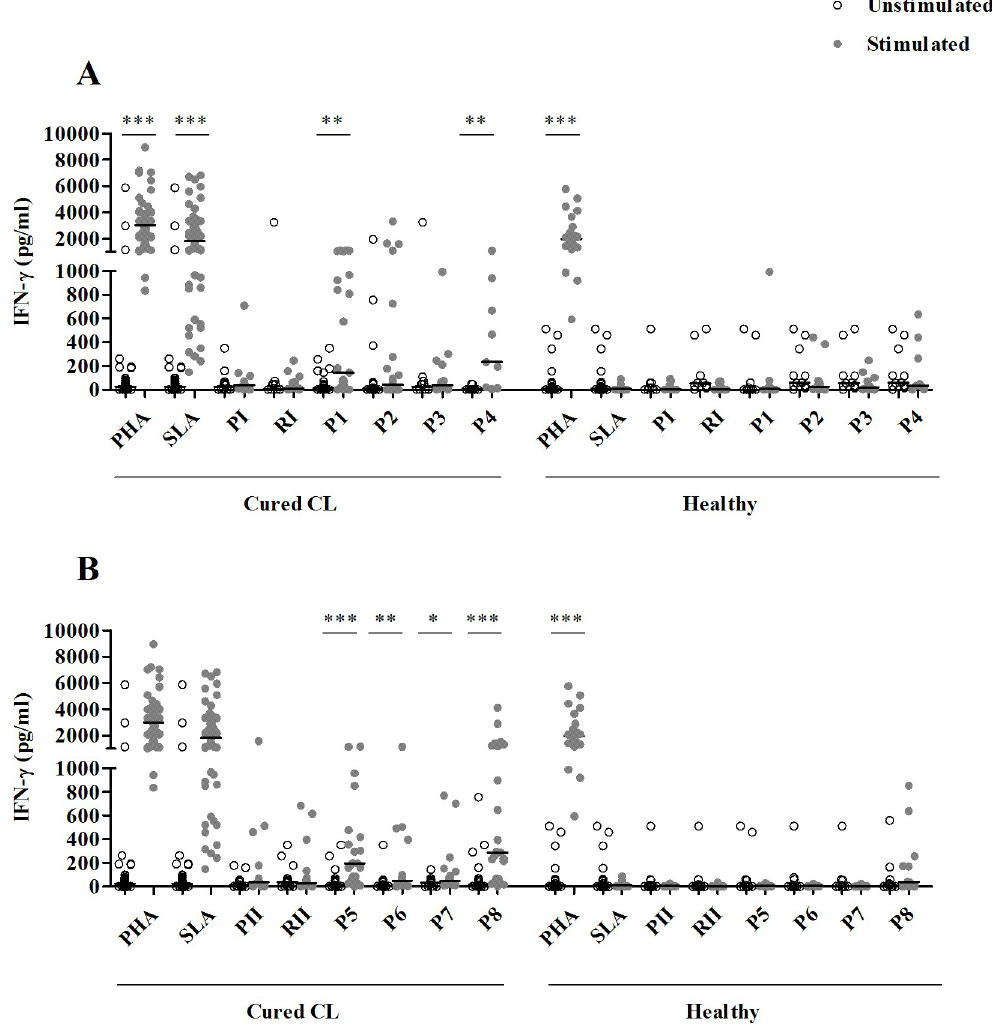
Fig 2. IFN- γ responses to pools composed of HLA-I or HLA-II peptides. IFN- γ was quantified by ELISA, in culture supernatants of PBMC from cured CL subjects (N = 23) or healthy individuals (N = 12) stimulated with peptide pools (1 μ M/peptide) composed of HLA-I ( A ) or HLA-II ( B ) peptides, for 10 days. PHA and SLA were used as positive controls (10 μ g/ml). Horizontal bars represent median values. Statistical significance was assigned to a value of p < 0,05 ( � p <